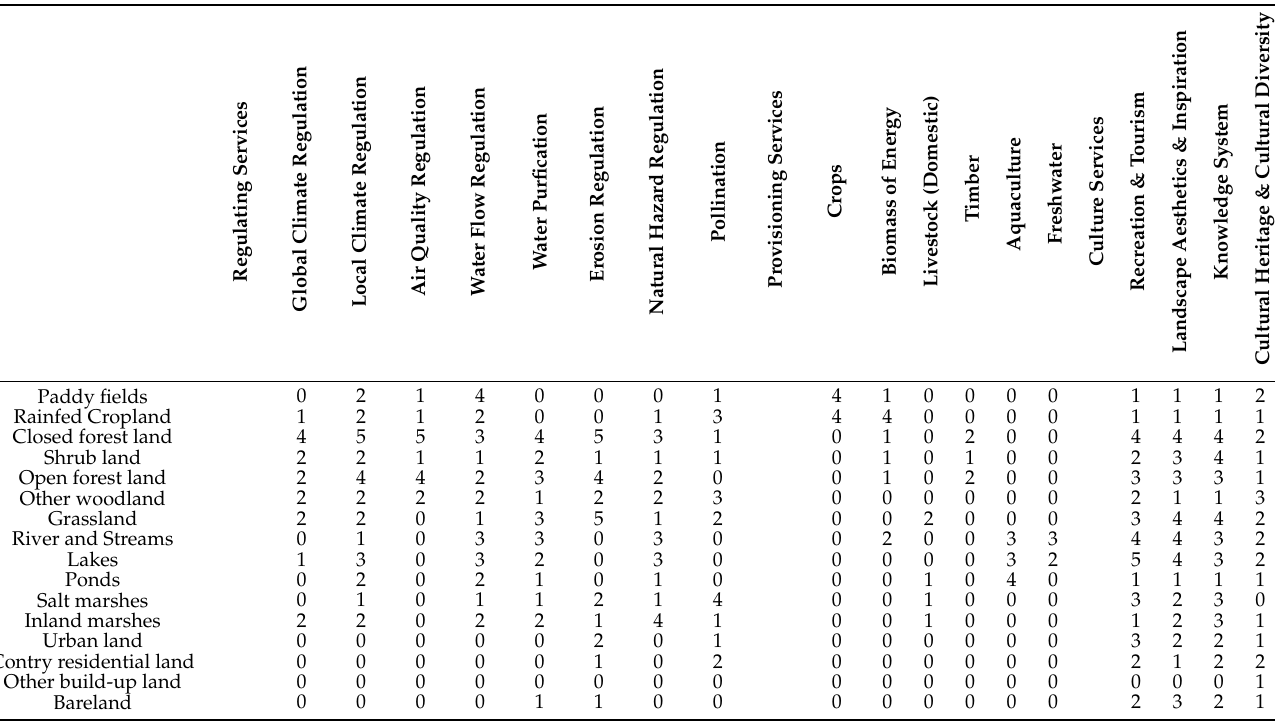
Table 4. Ecosystem services supply matrix. Scale from 0- = no relevant flow; 1 = low relevant flow; 2 = rele- vant flow; 3- = medium relevant flow; 4- = high relevant flow; and 5- = very high (maximum) relevant flow (After Burkhard et al., 2014).